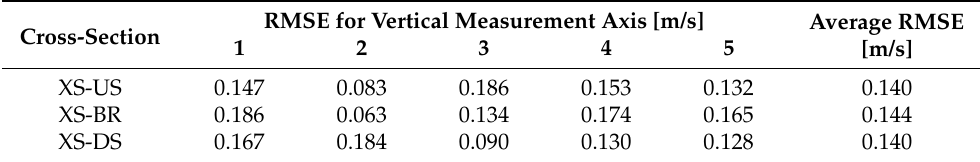
Table 4. Calculated RMSE between ADCP and ADVP